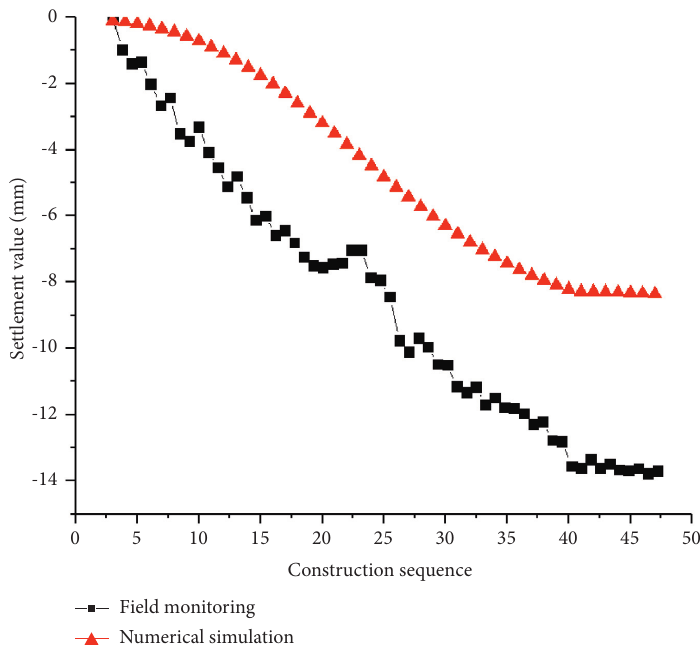
Figure 5: Comparison of the time-history curve of surface settlement of transverse